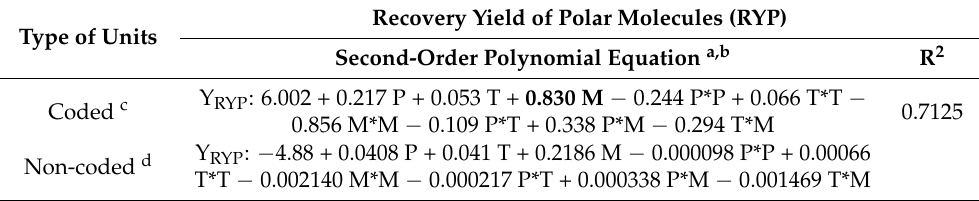
Table 7. Second order polynomial equations for the response of RYP for SC-CO 2 extraction of SCG. Type of